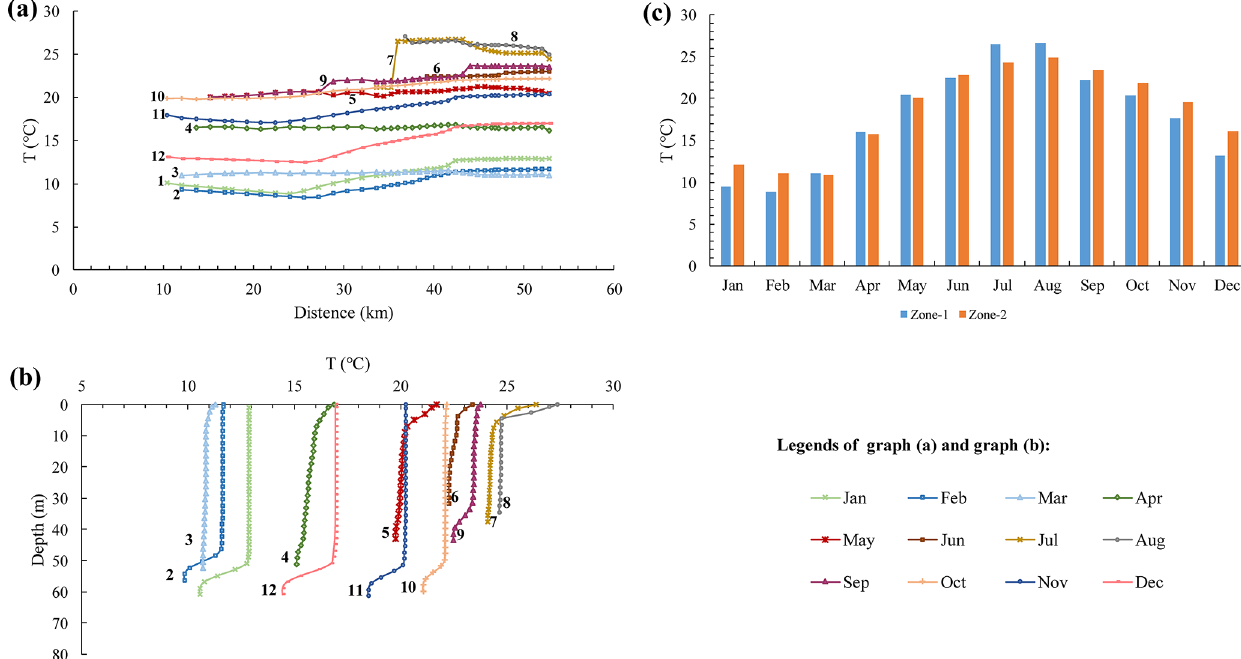
Figure 10. Changes in water temperature. (a) Variation in surface water temperature in each month along the tributary bay; (b) variation in the vertical water temperature at the confluence in each month; (c) average water temperatures of zone 1 and zone 2 in each month. The blue bar represents zone 1, and the orange bar represents zone 2 in panel (c)